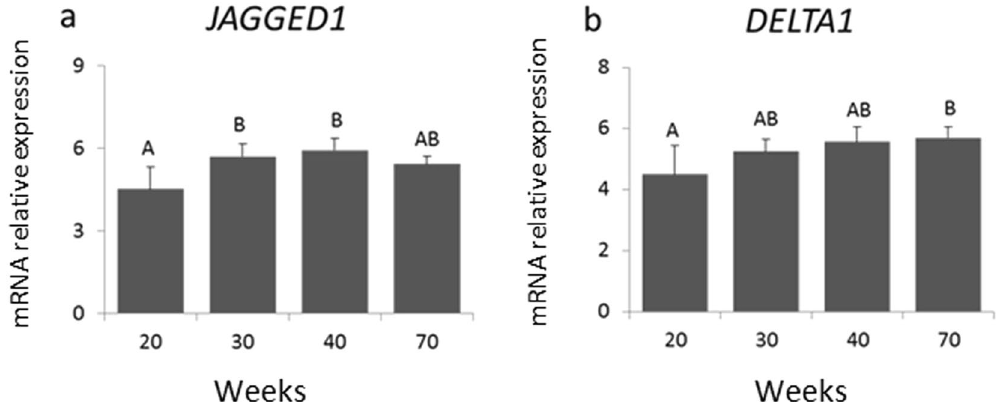
Figure 5. mRNA expression determined by qRT-PCR from Notch ligands JAGGED1 and DELTA1 , normalized to GAPDH , in the mammary glands from heifers aged 20, 30, 40 and 70 weeks (n = 5, 8, 9, 10 (a) ); (n = 3, 8, 7, 7 (b) ). Different letters on the top of the bars indicate statistical differences between ages (P <